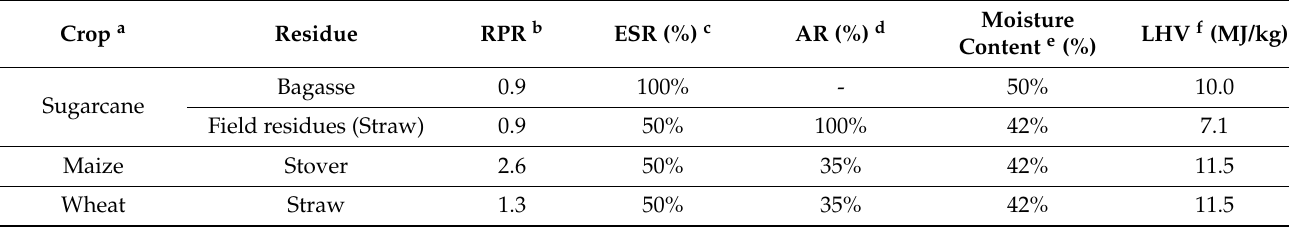
Table 3. Parameters considered for agricultural residues potential estimates in South Africa. Notes: a : Crop and residue production data were included in BioAtlas files [42]; b : Residue-to-product ratio determined by the ratio between lignocellu- losic residue yield and primary crop yield obtained in the Atlas metadata files [43,44]; c : 50% of residues should remain on field for soil conditioning [43]; d : Sugarcane bagasse availability data provided already discounted its use for internal energy demand. Sugarcane field residues are currently not available given the burning practice in sugarcane harvesting. However, this study considered that this practice will be extinguished in the near term in view of its environmental and health impacts. For wheat and maize residues, it was assumed that 35% are used for animal feed and bedding [13,43]; e : Moisture content of sugarcane bagasse was informed in the metadata available at SAEON Bioenergy Atlas website [42]. For other crops, moisture content values were obtained in [45]; f : Dry mass basis refer to air-dried biomass. In South Africa, average temperatures are high, and humidity is low. Then, air-dried lignocellulosic residues register a moisture content between 10% and 20%. Energy density is based on the generic values for agricultural residues [13]. For sugarcane bagasse, LHV was determined using the moisture and ash content and brix percentages [46].